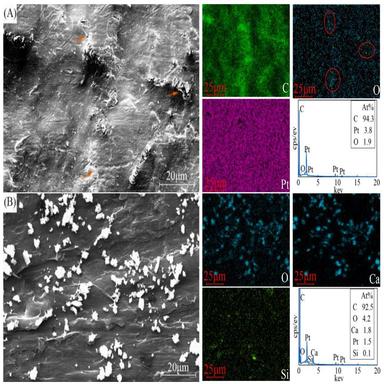
SEM surface images and EDS mapping of PE80 pipes: aged 10,104 h (A) and service 25 years (B).